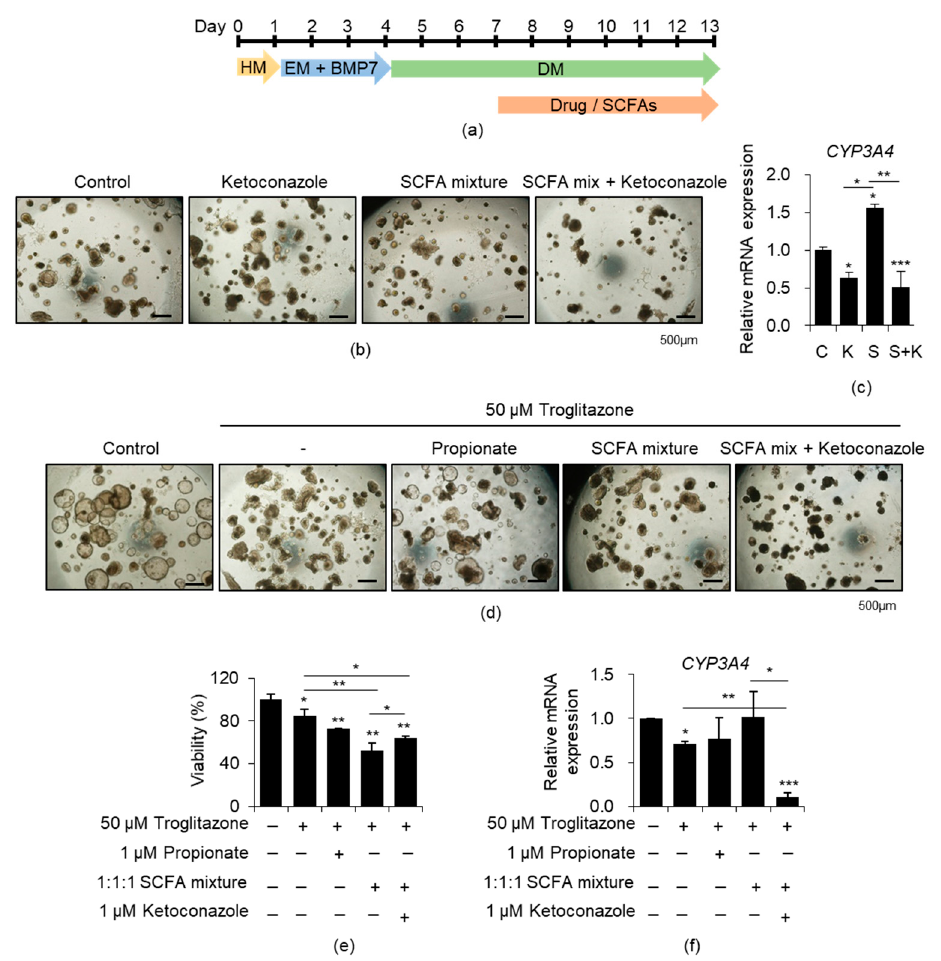
Figure 4. Effects of SCFAs on CYP3A4-mediated drug toxicity in iPSCs-derived liver organoids. ( a ) Scheme of drug and SCFAs treatment. ( b ) Representative morphology of DM-cultured organoids under each indicated treatment condition. ( c ) CYP3A4 mRNA expression levels under each indicated condition. ( d ) Representative morphology of the untreated control and the troglitazone (hepatotoxic drug)-treated group under each indicated condition. ( e ) Relative cell viability under each indicated condition. ( f ) CYP3A4 mRNA expression levels under each indicated condition. Data are presented as the mean ± SEM ( n = 3) and analyzed by Student’s t -test. * p < 0.05, ** p < 0.01, and *** p <